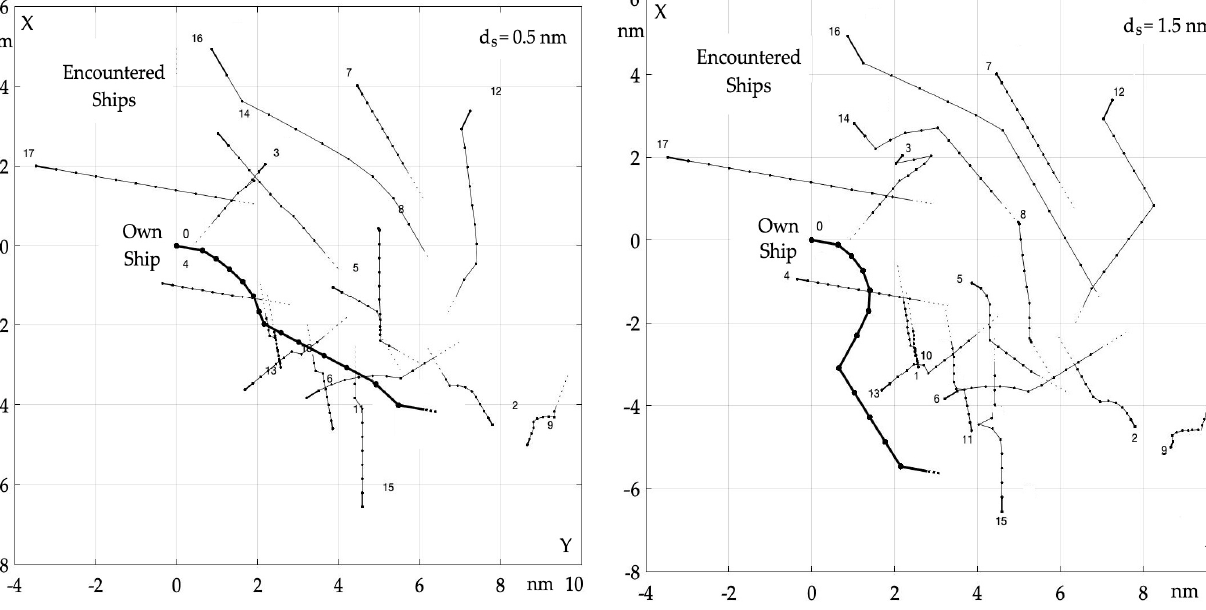
Figure 11. Autonomous surface ship safe path when passing K = 17 encountered other autonomous surface ships in good ( d s = 0.5 nm) and restricted ( d s = 1.5 nm) visibility at sea, determined by MG_n algorithm of non-cooperative matrix game. 202